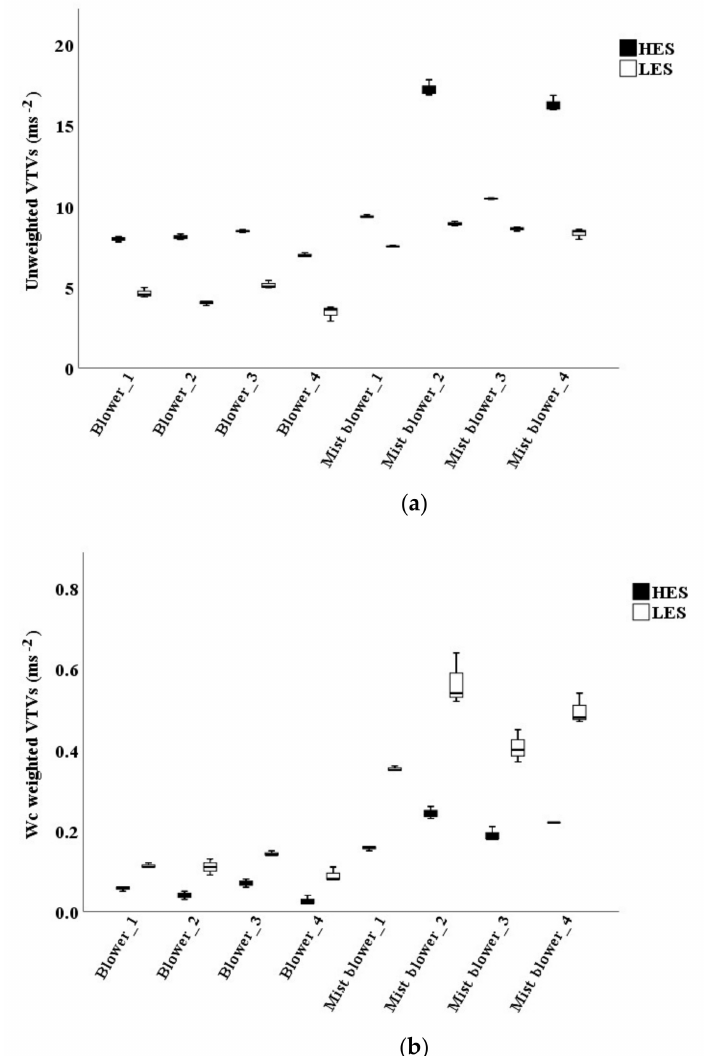
Figure 4. Vibration total values (VTVs) on the operators’ back of mist blowers and blowers: unweighted ( a ) and W c weighted ( b ). LES: low engine speed; HES: high engine